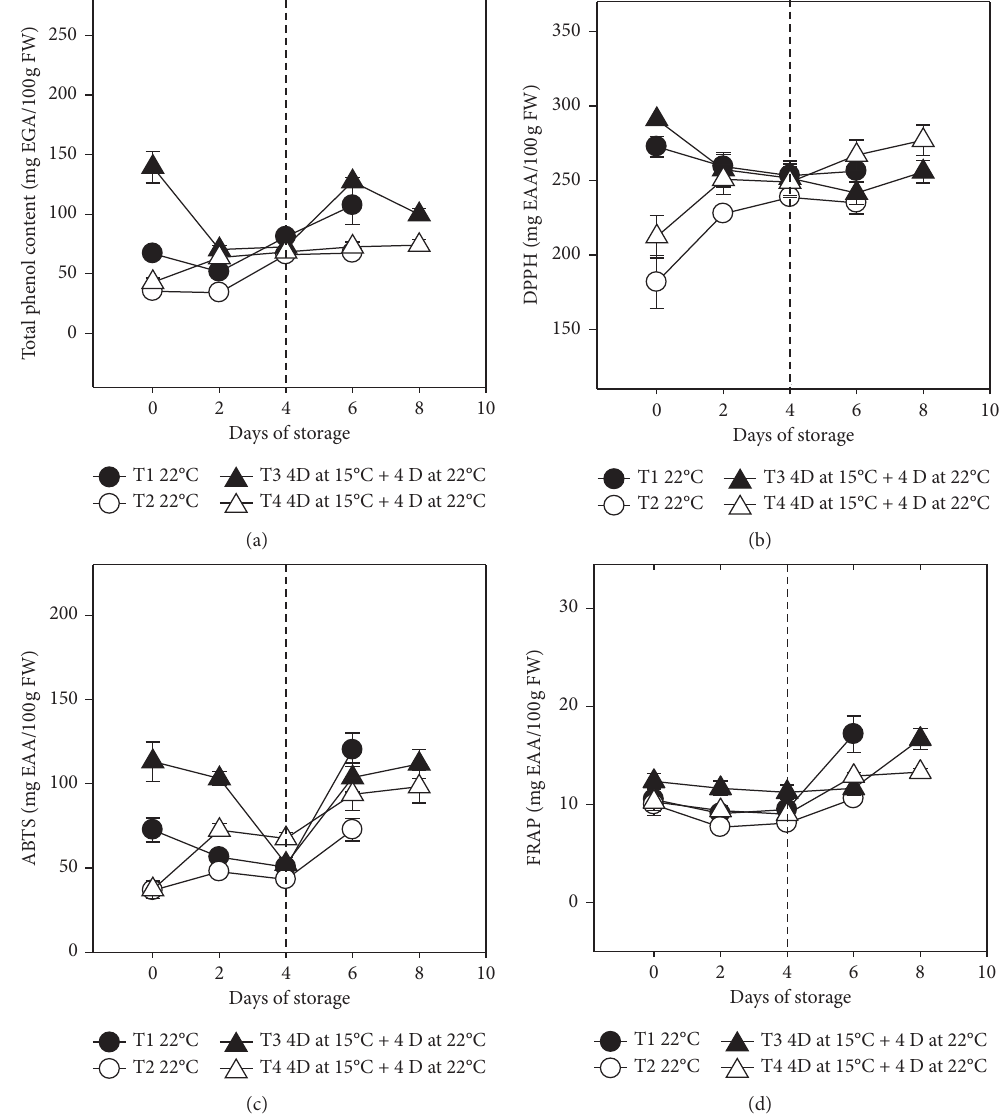
Figure 3: Total phenols content and AOX (ABTS, DPPH, and FRAP) in soursop fruits at 22 ° C and 15 ° C. Each point represents the average of 6 observations and its standard error. The dotted line indicates the end of refrigerated